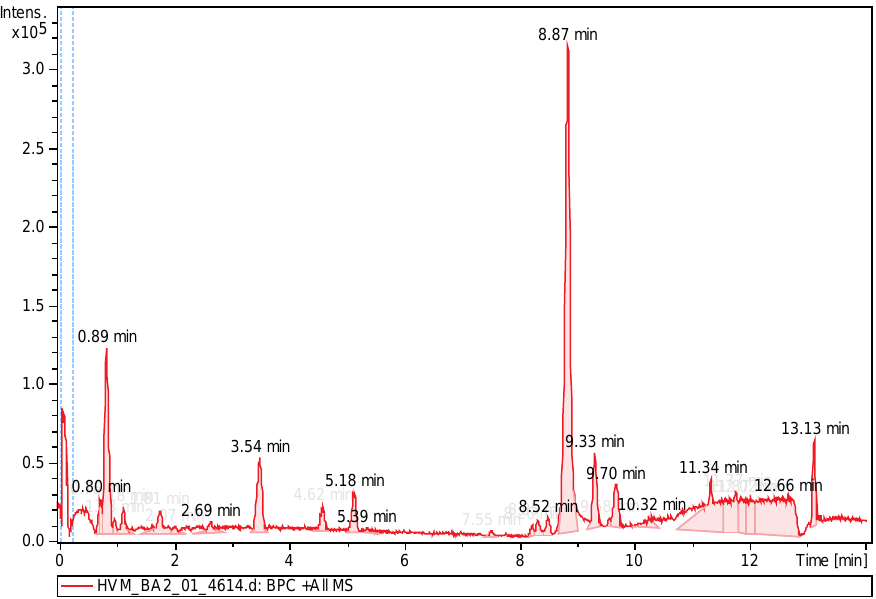
Figure 1. Base peak chromatogram (BPC) of the aqueous extract from w VM.